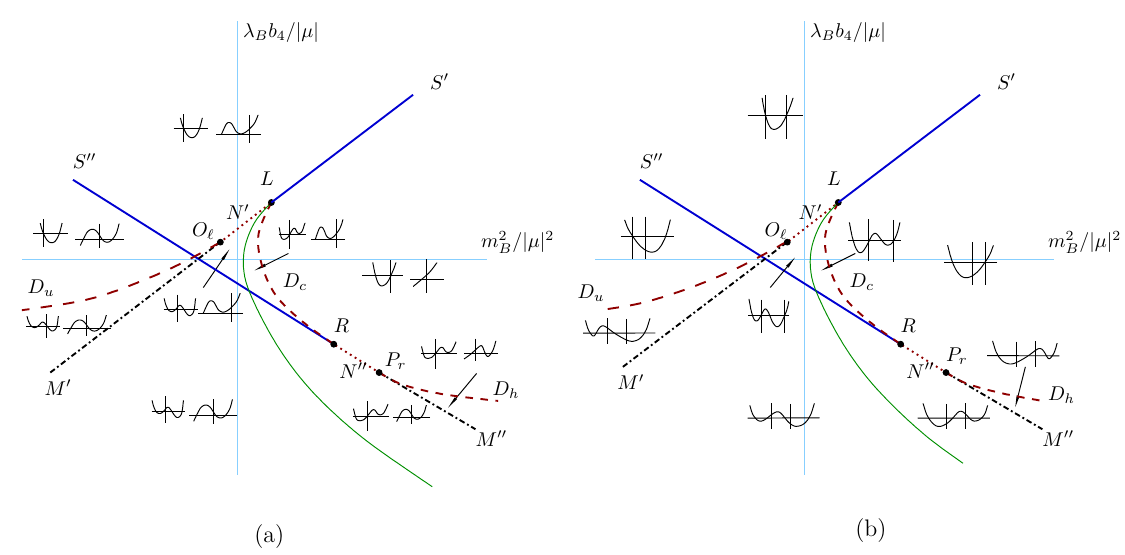
Figure 15 . Structure of the potential for 0 < x B < φ u . We have restored the | µ | dependence of 6 the phase diagram by rescaling m 2 and λ B b 4 by appropriate powers of | µ | . The green curve is a B first order transition while the blue curves are second order transitions. The above plot is for the subrange 0 < x B < 1 ( φ h + φ u ) where the first order curve goes to infinity in the fourth quadrant. 6 2